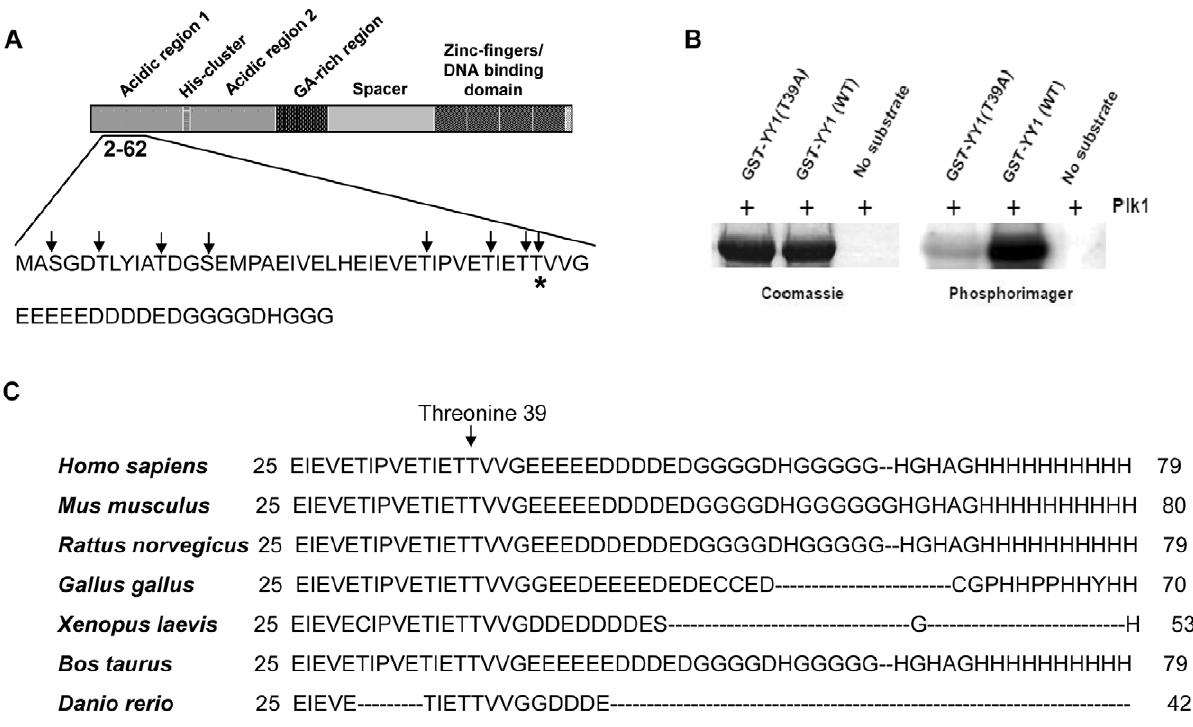
Figure 3. Plk1 phosphorylates YY1 at threonine 39 invitro . ( A ) Diagram displaying the different domains of the YY1 protein. Amino acid residues 2–62 are shown; serine and threonine residues in amino acids 2–62 are indicated by arrows. The predicted phosphorylation site at threonine 39 is indicated with a star. ( B ) Coomassie blue staining and phosphorimager exposure of the SDS-PAGE gel analysis of the radioactive in vitro kinase assay reactions. Kinase reactions include Plk1 only (no substrate lane), Plk1 with GST-YY1 wild type (WT) or mutant (T39A). ( C ) Amino acid sequence alignment of the N-terminal domain of the YY1 protein from different species, as indicated.